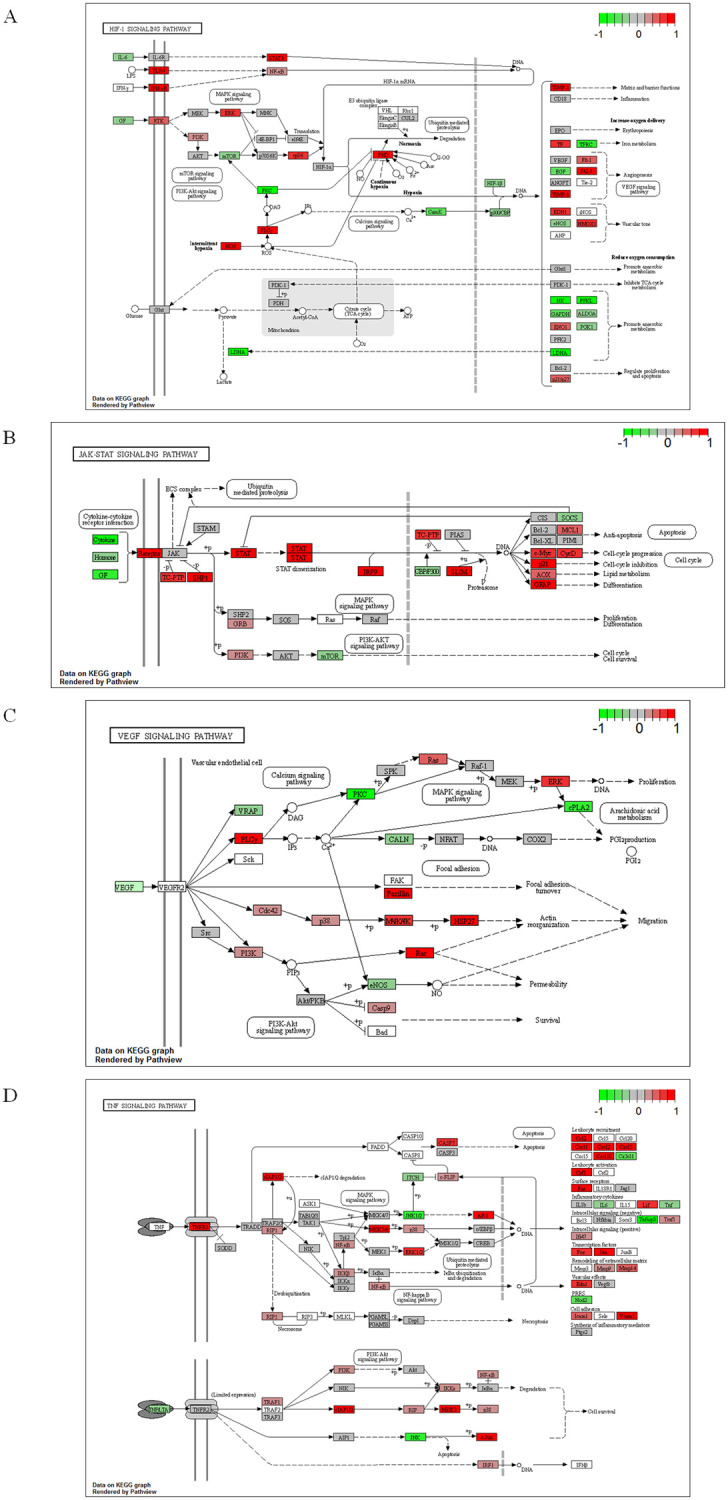
Visualization of gene expression profiles in KEGG pathway mapping.Each cell represents the log2 ratio gene expression data of the RVO group normalized to the control group. The coloration indicates upregulated (Red) and downregulated (Green) genes. Pathway maps of (A) HIF-1α, (B) VEGF, (C) TNFα, and (D) JAK-STAT signaling pathways. The analysis was performed using the R pathview package.